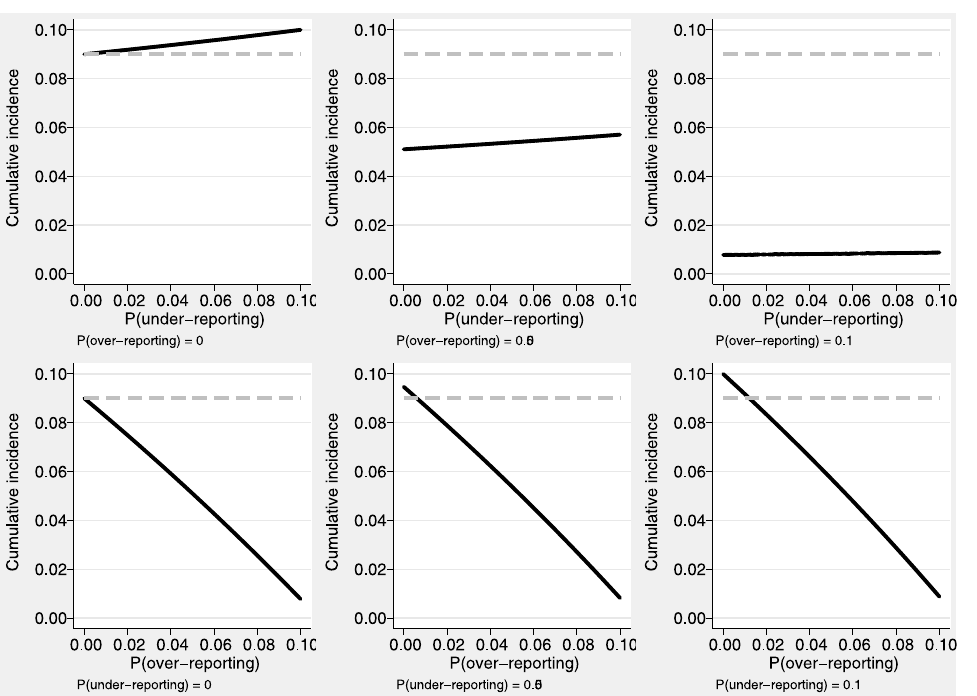
Fig 6. Sensitivity analysis regarding the effect of the potential misclassification of cancer. The cumulative incidence of the observed cancer deaths at 10 years after cancer diagnosis was 0.09 (grey dashed lines). The corrected cumulative incidence estimates (solid black lines) are presented according to the different potential levels of cancer death under-reporting (first row) and over-reporting (second